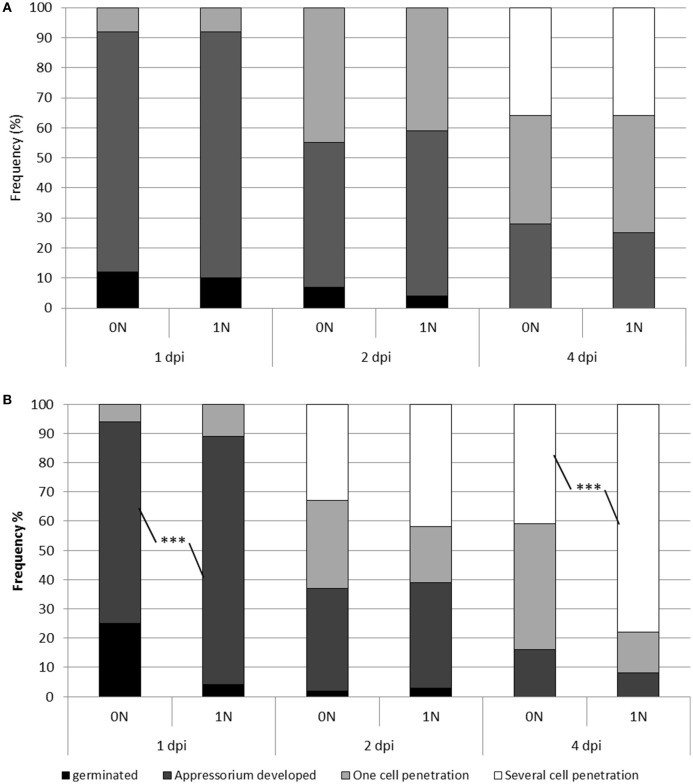
Penetration and growth of M. oryzae in rice plants under different nitrogen regimes. Low or high nitrogen fertilization (0N and 1N; see Section Materials and Methods) was applied to Nipponbare (A) and Kasalath (B) plants which were subsequently inoculated with the Guy11 isolate. At the indicated time after inoculation (1, 2, and 4 dpi), the developmental stage of the fungus was evaluated. Four types of situations were counted: a spore that germinated but did not develop an appressorium (black), a spore with a developed appressorium (dark gray), sites where the fungus had penetrated one cell (light gray) and sites where the fungus had penetrated several cells (white). For each time x treatment combination, a total of 100 events were counted. This experiment was repeated three times and one representative experiment is shown. A Chi square test was used to compare the different percentages (see text). ***P < 0.001.